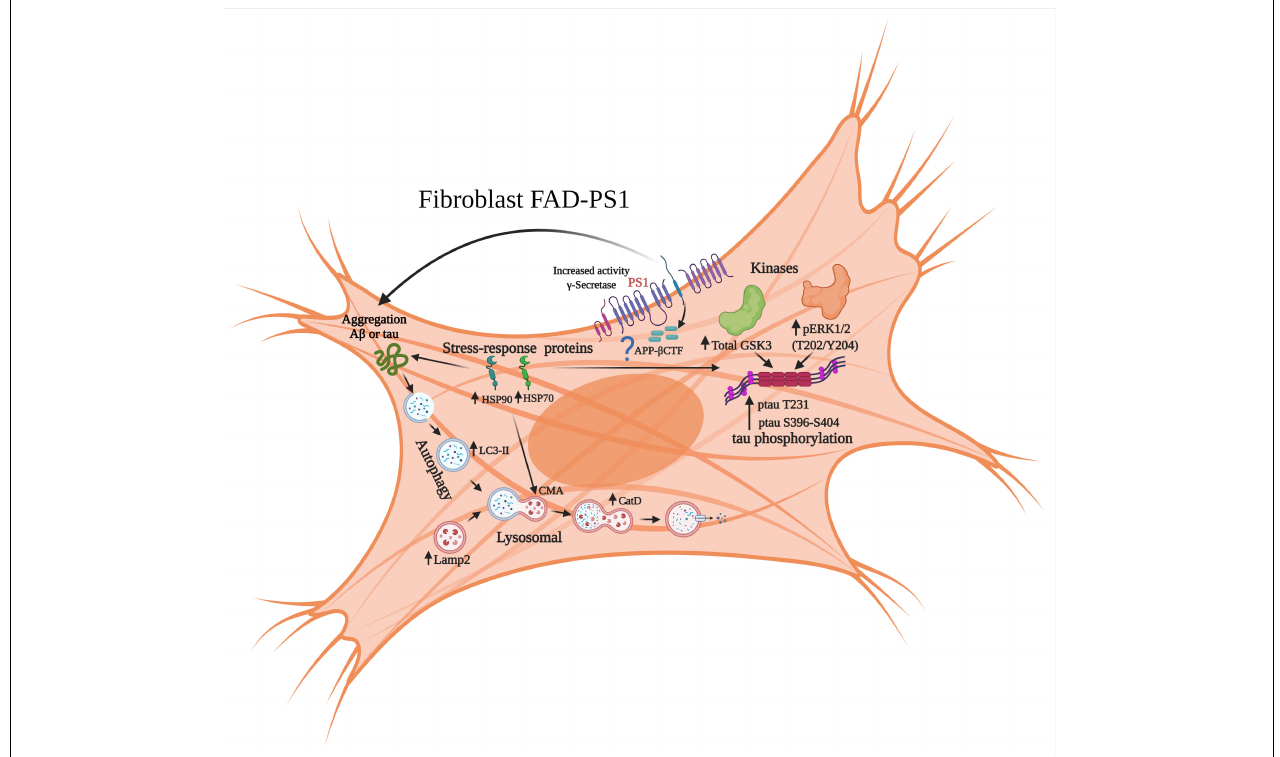
FIGURE 10 | Molecular alterations in signaling pathways associated with neurodegeneration in fibroblasts derived from patients with FAD- PS1 . The results of gene expression of brain samples from patients with ADF allowed for the identification of changes at the level of the autophagic-lysosomal pathway, as well as of kinases associated with hyperphosphorylation of the protein tau and its pathological phosphorylation. From the proteomic results, it was identified that fibroblasts with PS1 mutations present increased levels of cellular stress proteins, which could represent a compensation event through chaperone-mediated autophagy and also regulate the aggregation of the A β peptide and